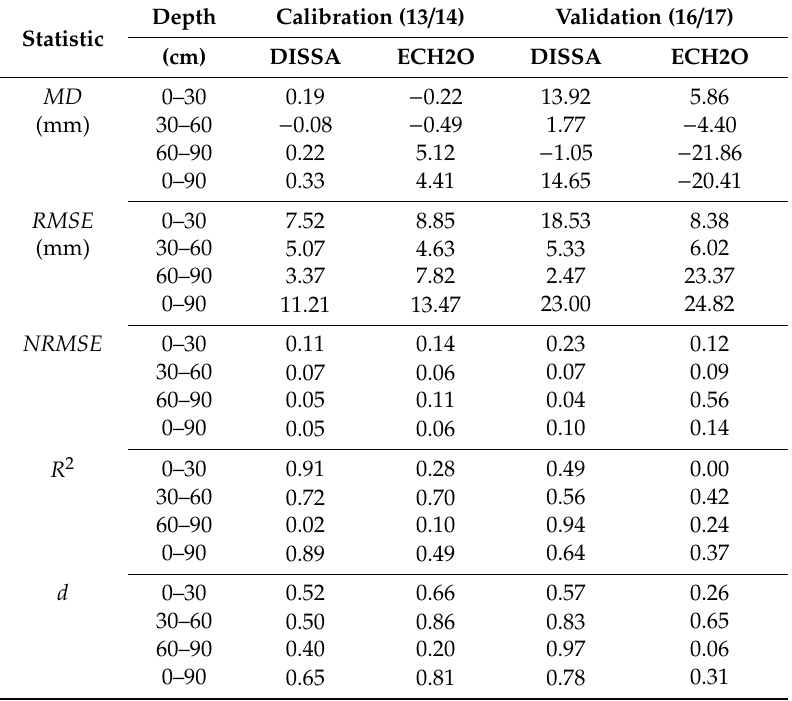
Table 4. Statistical comparisons between observed and simulated soil water depth for fallow